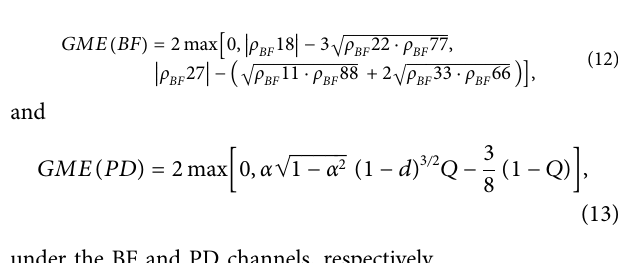
Frontiers in Physics |